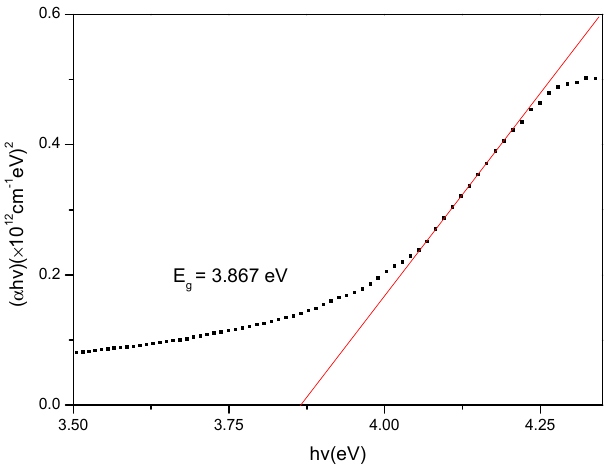
Figure 6. Optical band gap for CGQD thin film.